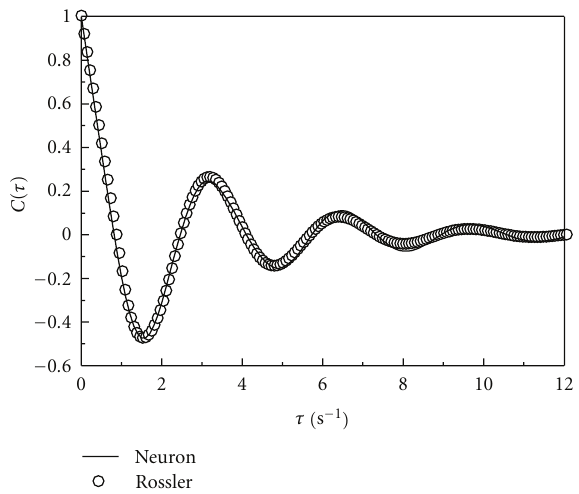
Figure 6: Autocorrelation functions for the telegraph signals corresponding to a spontaneous activity of a hippocampal (cid:2) CA3 (cid:3) singular neuron (cid:2) solid curve (cid:3) and to the spike train generated by the R¨ossler attractor fluctuations overcoming a threshold (cid:2) circles (cid:3) . In order to make the autocorrelation functions comparable a rescaling has been made for the R¨ossler autocorrelation function. The data has been taken from (cid:4) 10 (cid:5)